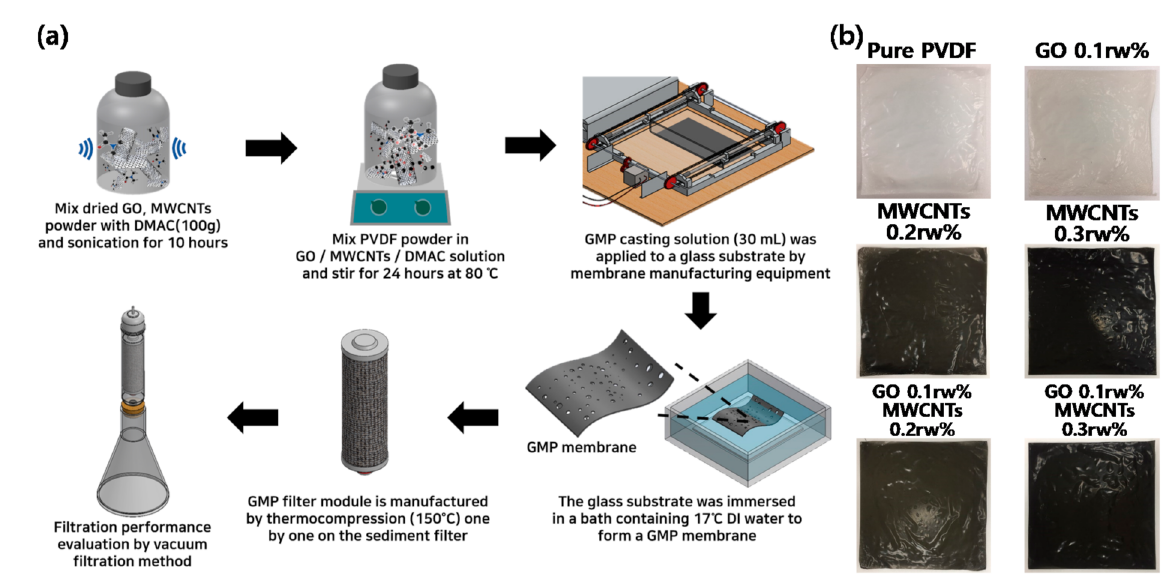
Figure 1. ( a ) The process schematic of GMP membranes and ( b ) digital photograph of the membrane by